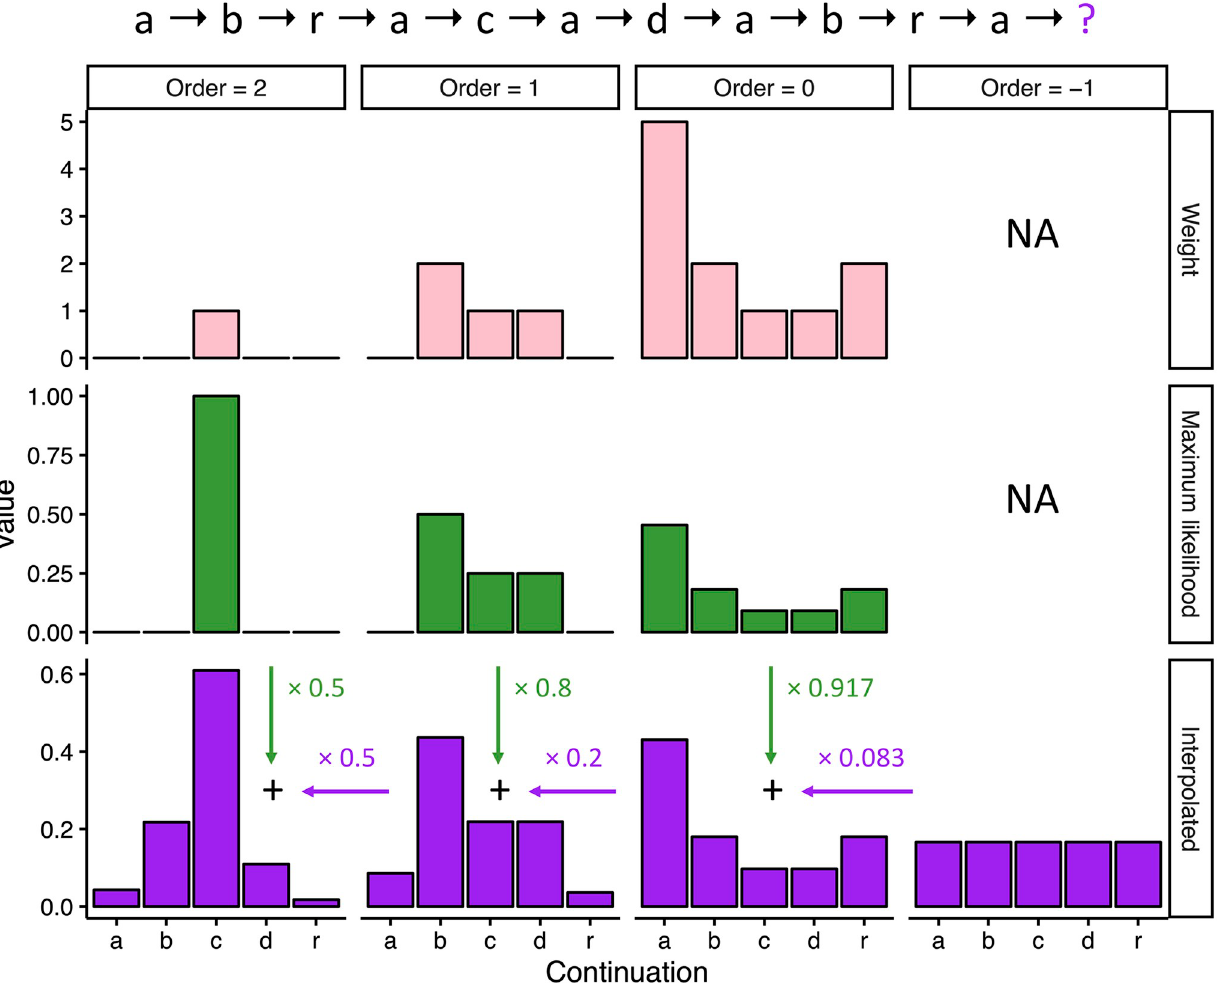
Fig 11. Illustration of the interpolated smoothing mechanism. This smoothing mechanism blends together maximum-likelihood n -gram models of different orders. Here the Markov order bound is two, the predictive context is “abracadabra”, and the task is to predict the next symbol. Columns are identified by Markov order; rows are organized into weight distributions, maximum-likelihood distributions, and interpolated distributions. Maximum- likelihood distributions are created by normalizing the corresponding weight distributions. Interpolated distributions are created by recursively combining the current maximum-likelihood distribution with the next-lowest-order interpolated distribution. The labelled arrows give the weight of each distribution, as computed using escape method “A”. The “Order = − 1” column identifies the termination of the interpolated smoothing, and does not literally mean a Markov order of −